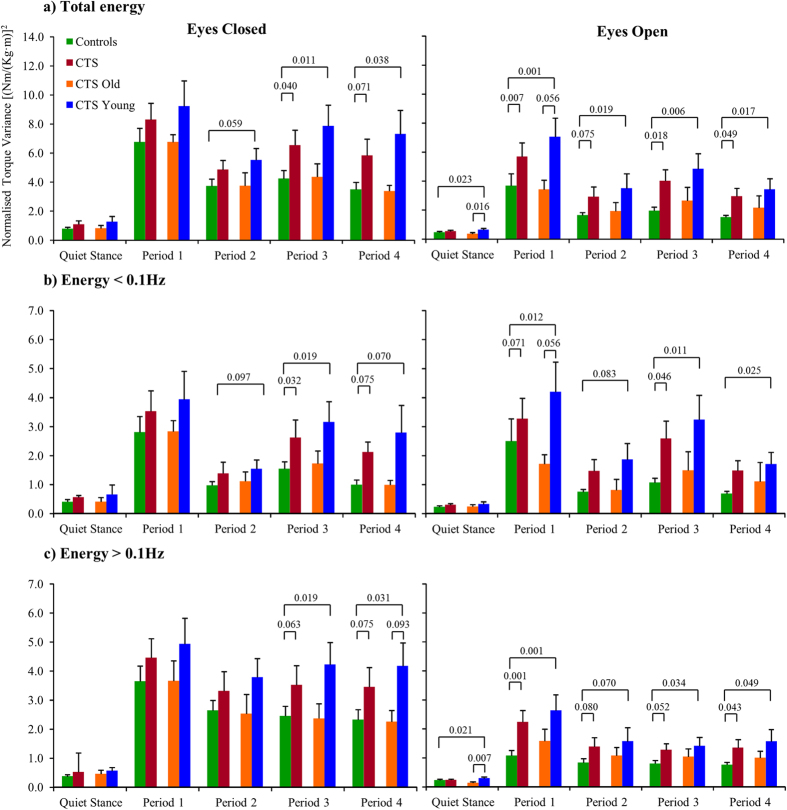
Total, low frequency and high frequency spectral energy used towards the supporting surface during the 5 sequential time periods during posturography.The figure present normalised; (a) total, (b) low frequency and (c) high frequency torque variance values, representing kinds of spectral energy, used during posturography while standing with Eyes Closed and Eyes Open (mean and SEM). Values and statistical findings to the level of trends (p < 0.1) are presented for healthy controls (n = 25), for all chemotherapy treated subjects CTS (n = 16), and for the subgroups CTS treated with chemotherapy below 12 years of age CTS_Young (n = 10) and CTS treated from 12 years of age and older CTS_Old (n = 6).